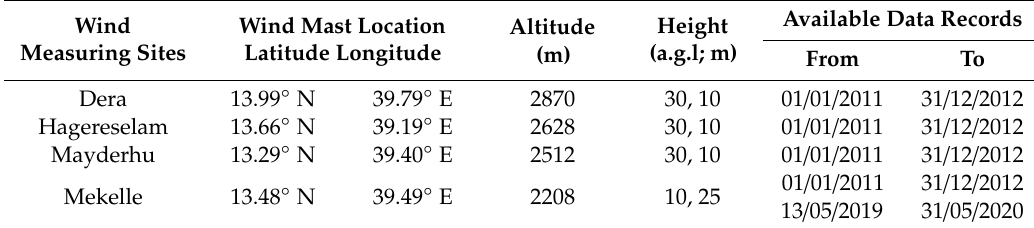
Table 1. Summary of wind measurement sites in Geba